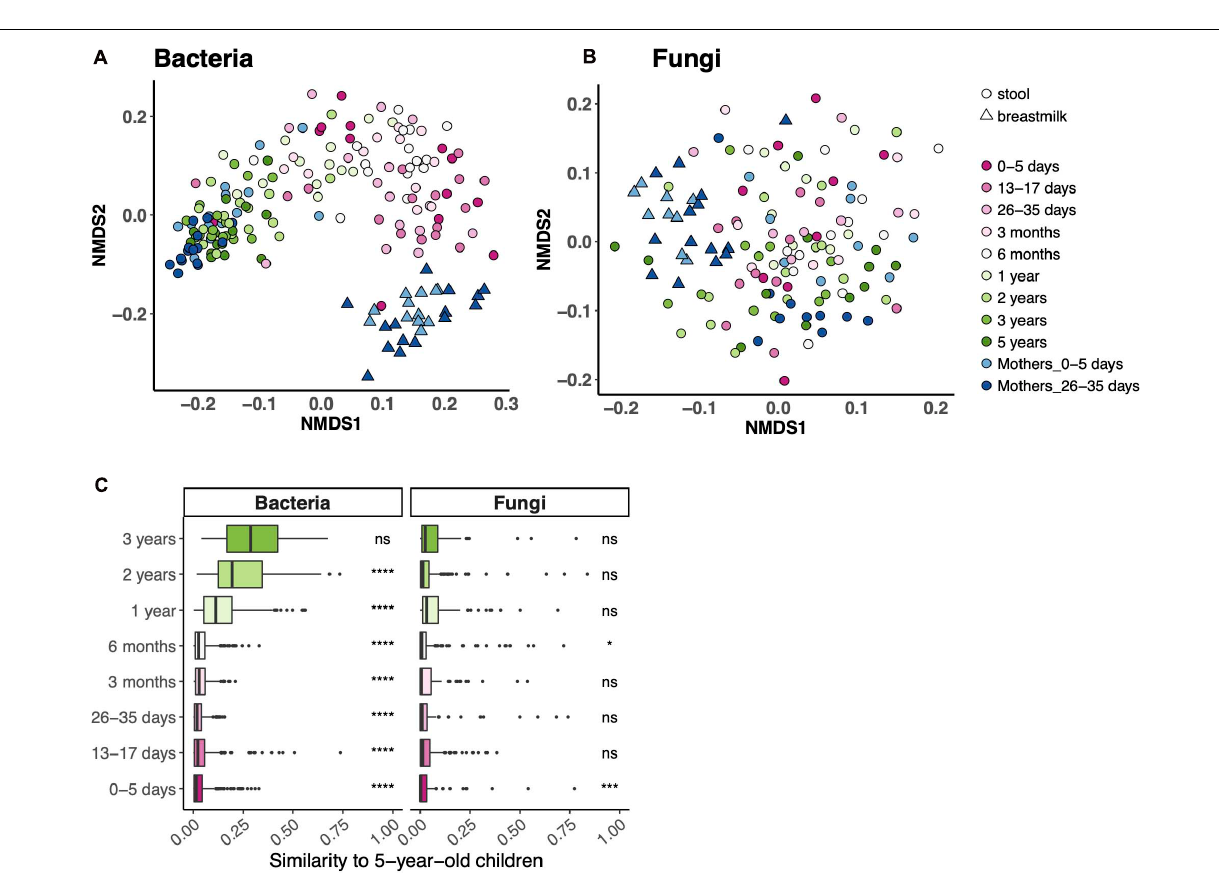
FIGURE 2 | Bacterial and fungal communities across the age spectrum. (A,B) Ordinations of community composition based on Bray–Curtis distance for bacterial (A) and fungal (B) fecal communities. (C) Bray–Curtis distance between each age bin and 5 years. **** p < 0.0001, *** p < 0.001, * p < 0.05, Wilcoxon rank-sum test, adjusted using the Bonferroni